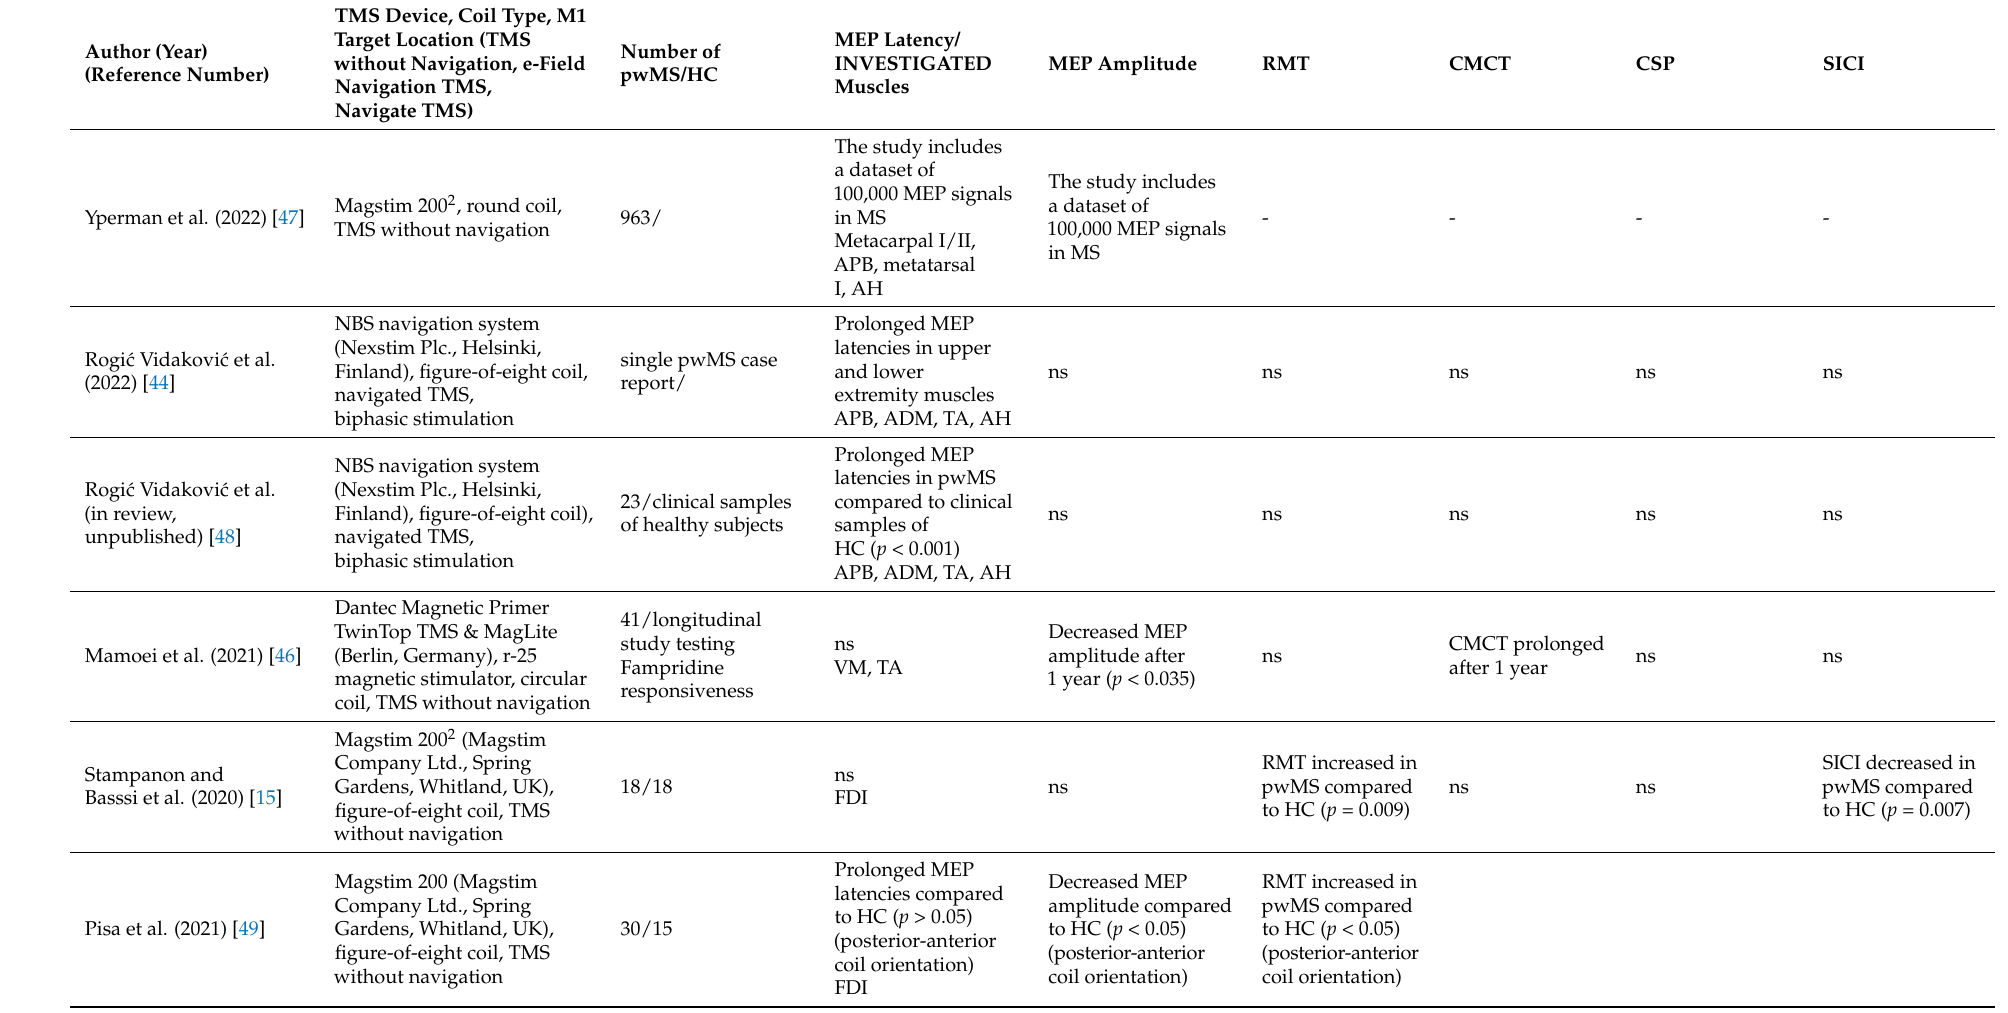
Table 1. An overview of TMS studies examining the central and peripheral systems in